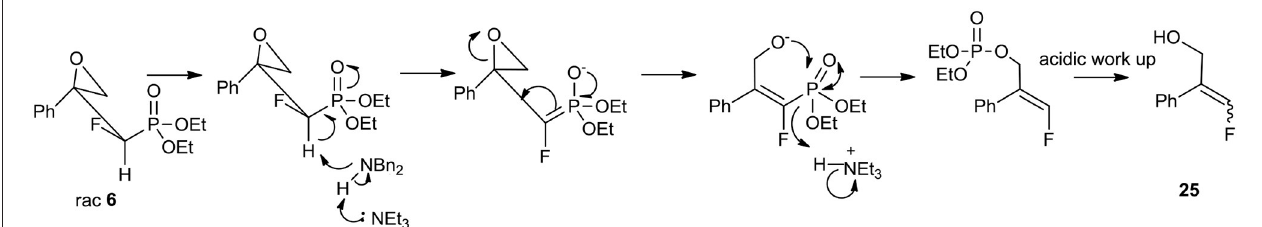
SCHEME 2 | Mechanism of transformation of 6 to 25 during reaction with Bn 2 NH and TEA.